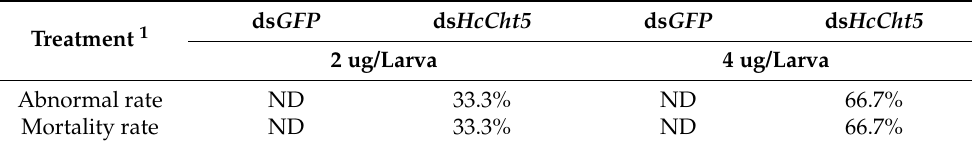
The abnormal rate and mortality rate of H. cunea after injection of ds HcCht5 in different concentrations.